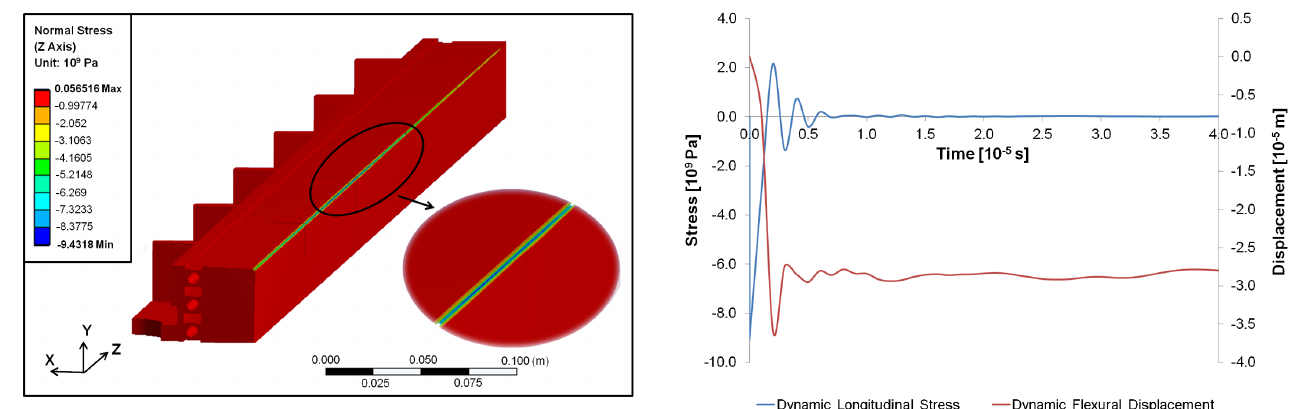
FIG. 22. Dynamic flexural displacement ( x -direction) and dynamic longitudinal stress ( z -direction) on the collimator jaw assembly at z ¼ 0 . 42786 m, as provoked by the particle beam impact during the first few μ s. It can be observed that oscillations start at a frequency range on the order of kHz.